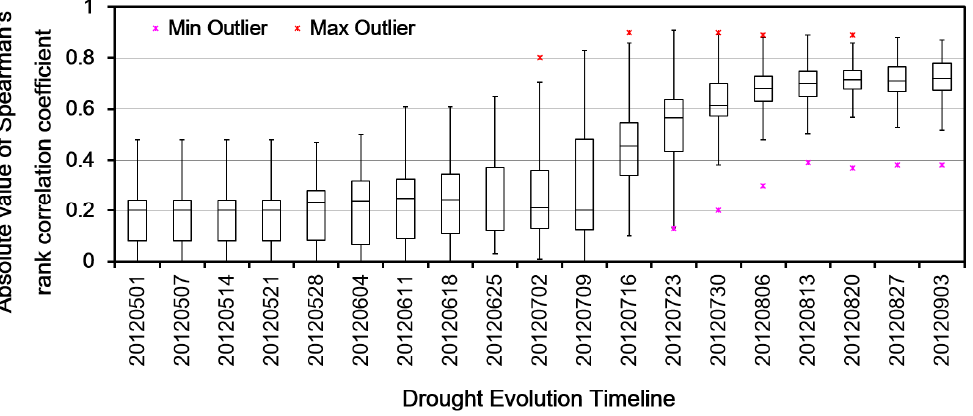
Figure 9. Box plots of correlations between YAI and PADI from the beginning of drought to the end in twelve states in the Midwest. Spearman’s correlation coefficients were considered only at significant level of 1%.